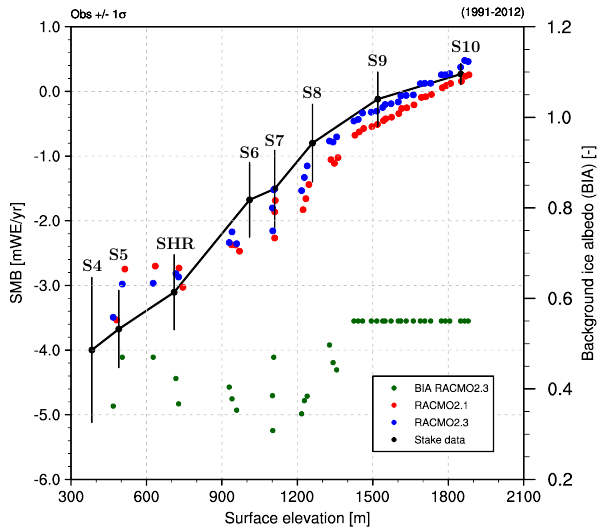
Figure 9. Observed and simulated SMB (mWEyr − 1 ) along the K- transect in west Greenland ( ∼ 67 ◦ N), averaged for the period 1991– 2012. The observed SMB (black dots) at S4, S5, SHR, S6, S7, S8, S9 and S10 are based on annual stake measurements. S10 observa- tions cover 1994–2010. The black bars represent the standard devi- ation ( ± 1 σ ) around the 1991–2012 mean value. Modelled SMB at stake sites and intermediate locations are displayed for RACMO2.3 (blue dots) and RACMO2.1 (red dots). MODIS background ice albedo as prescribed in RACMO2.3, is depicted in green (axis on